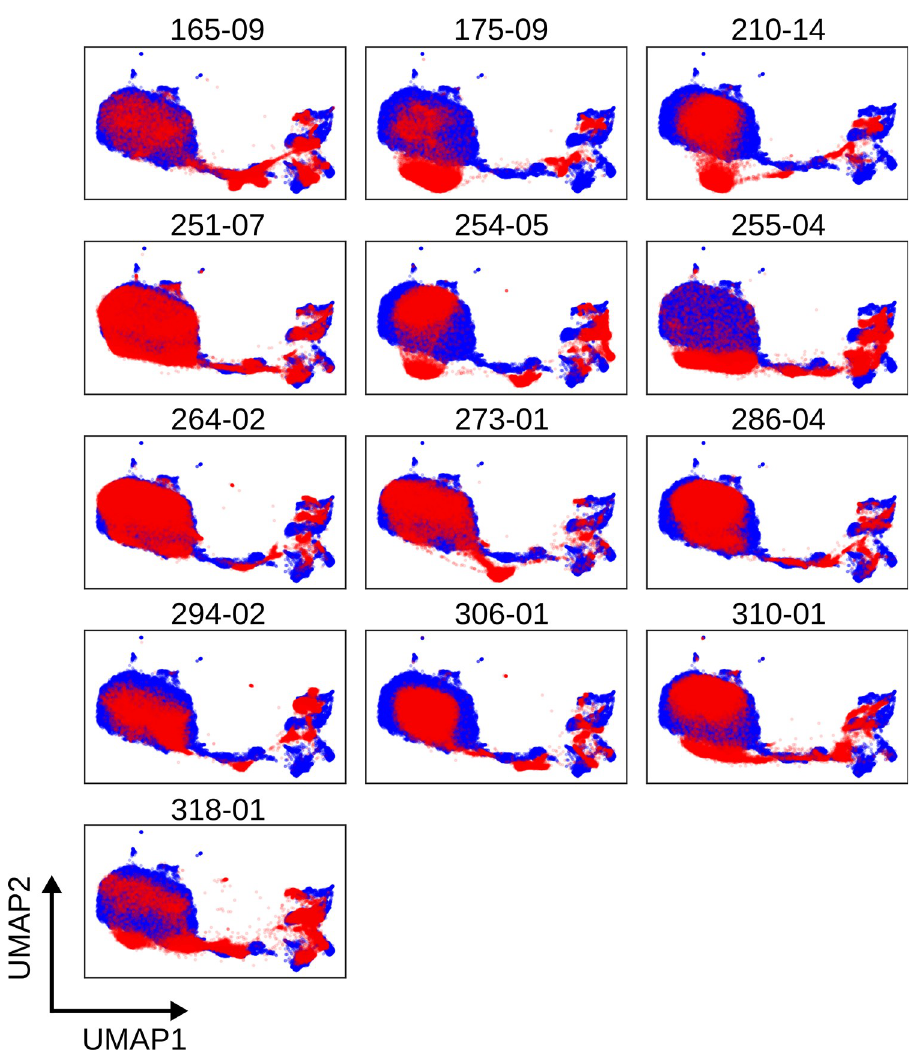
Fig 2. UMAP plots revealing batch effect in T cell staining of whole blood. A reference sample (blue) is chosen as the ‘average’ sample in Euclidean space. A low dimension embedding of this sample is made using UMAP (other algorithms are available in CytoPy, e . g . PCA, PHATE, t-SNE) and samples for comparison are projected into this same space (red), demonstrating ‘drift’ in cell populations between patient samples. Each plot depicts results obtained with cells from an individual patient; numbers shown are unique patient sample